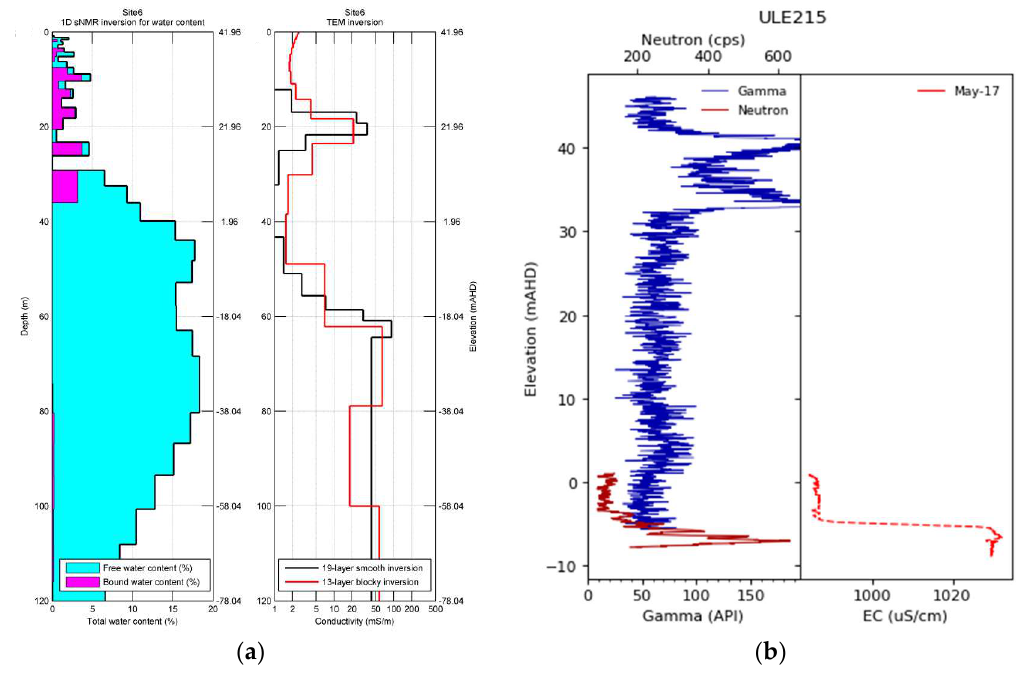
Figure 14. ( a ) sNMR total water content and conductivity profile at Site 6 [20]; ( b ) Gamma, neutron, and EC profiles for ULE 215 (surveyed ground elevation 45.7 m AHD. There is a discrepancy in SRTM [26] based elevation used at Site 6 compared to the surveyed elevations).